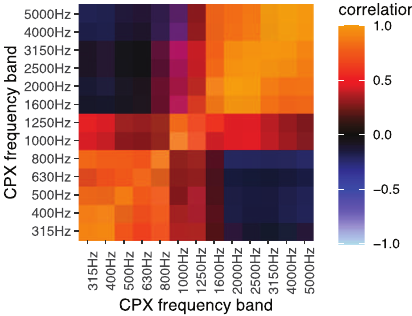
Figure 3. Pearson autocorrelation matrix of the CPX one-third octave bands.